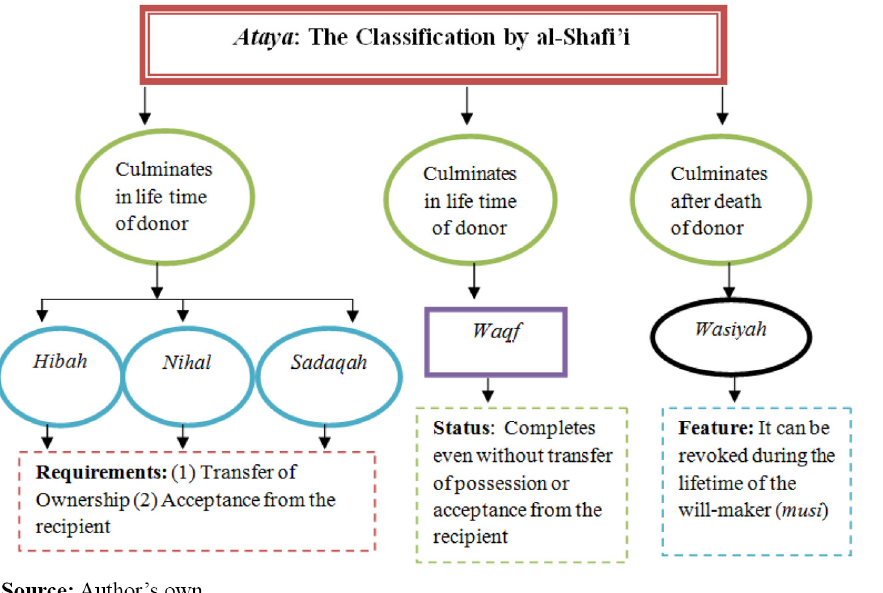
Figure 1. Categorisation